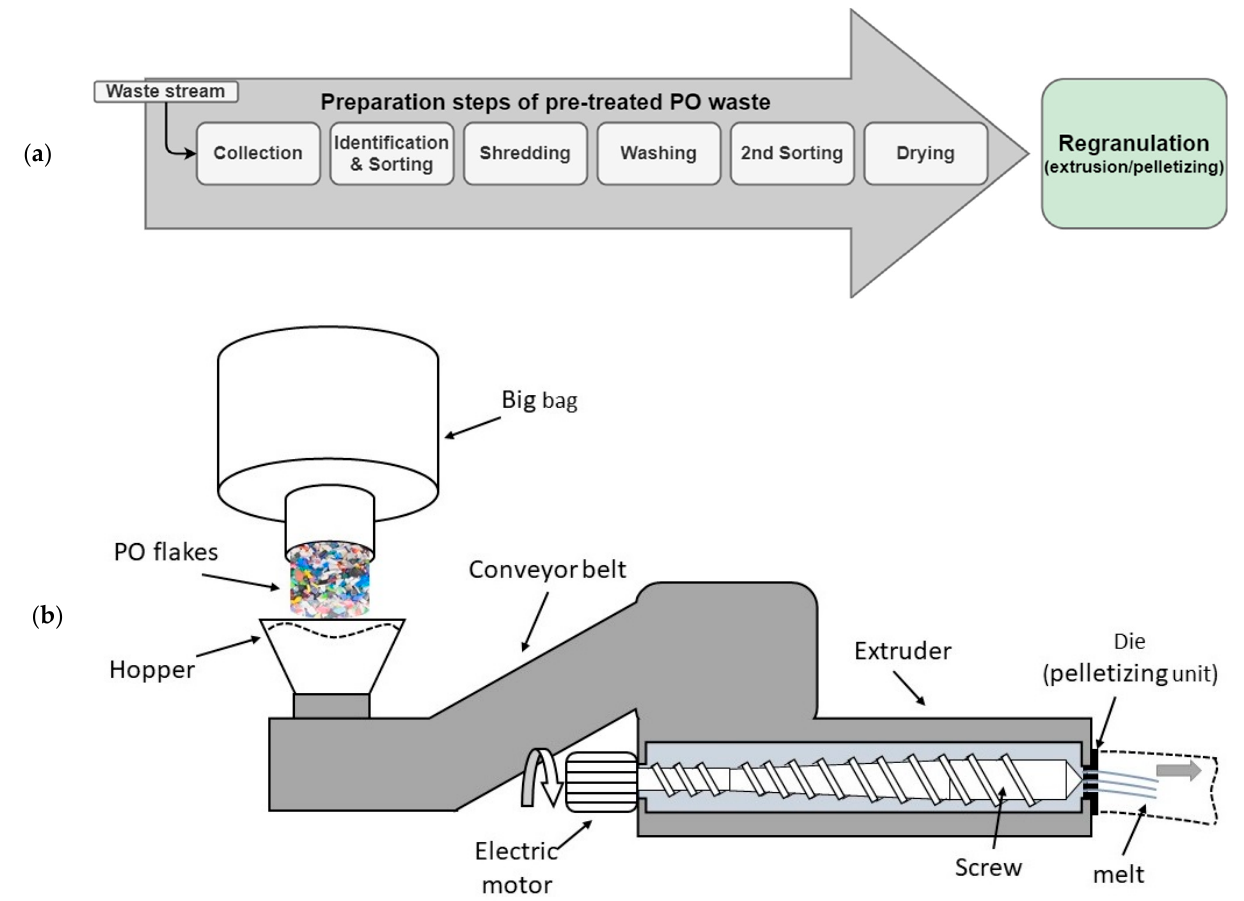
Figure 2. ( a ) Simplified sequence of the preparation steps of the pretreated polyolefin (PO) flakes based on ISO 15270:2008 [38], ( b ) schematic representation of the regranulation process on a machine equipped with a single screw extruder. This representation is inspired by the process set-up at LIT Factory, Linz, Austria (own illustration).